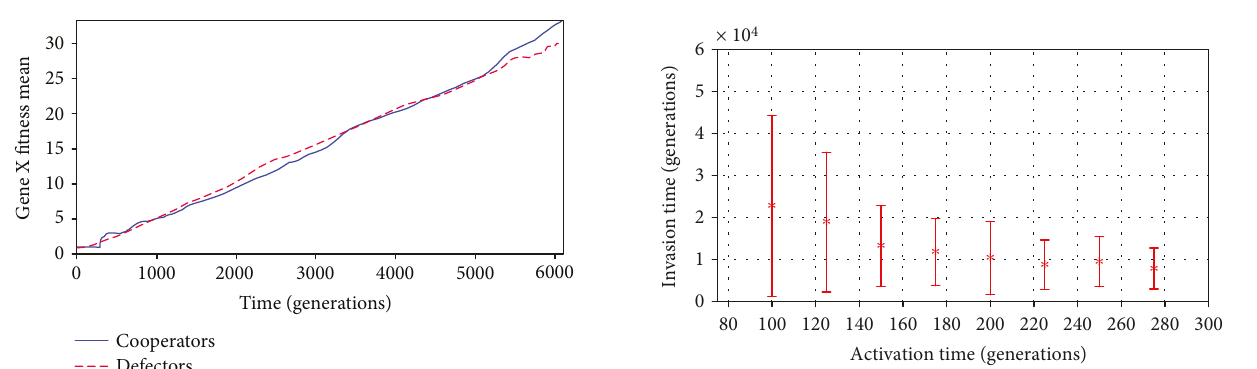
Figure 17: Evolution of the mean of fi tness due to gene X for cooperators and defectors during the simulation.